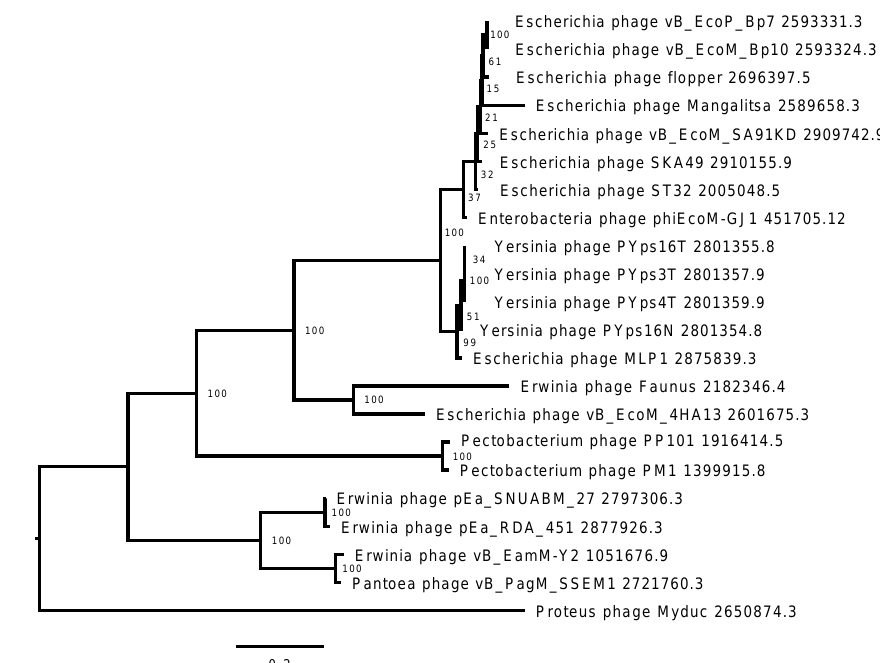
Figure 6. Phylogenetic tree of 4HA13 and its VIRIDIC clade members. The tree was constructed using PATRIC’s PGFams using 10 genes and an allocation of 3 genome exclusions.